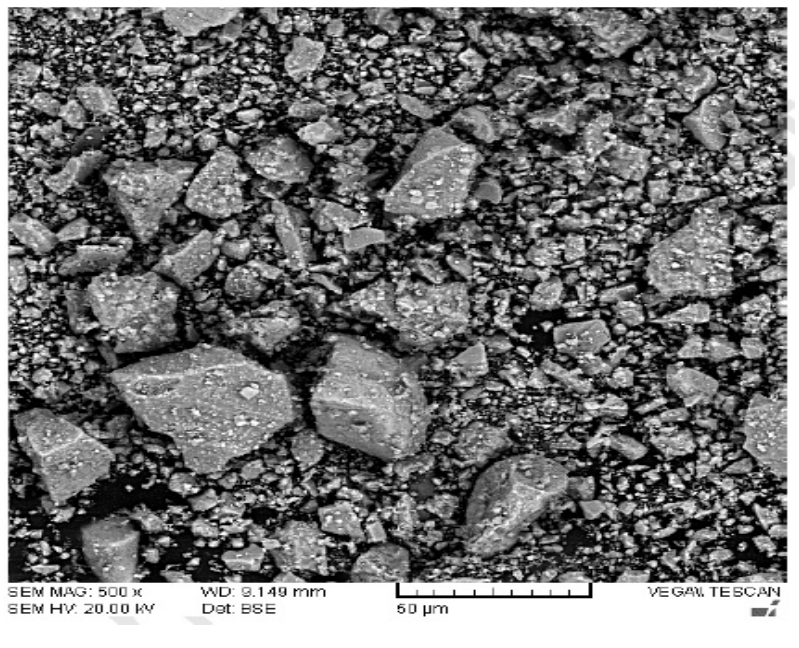
Figure 3. SEM of CPS [49].